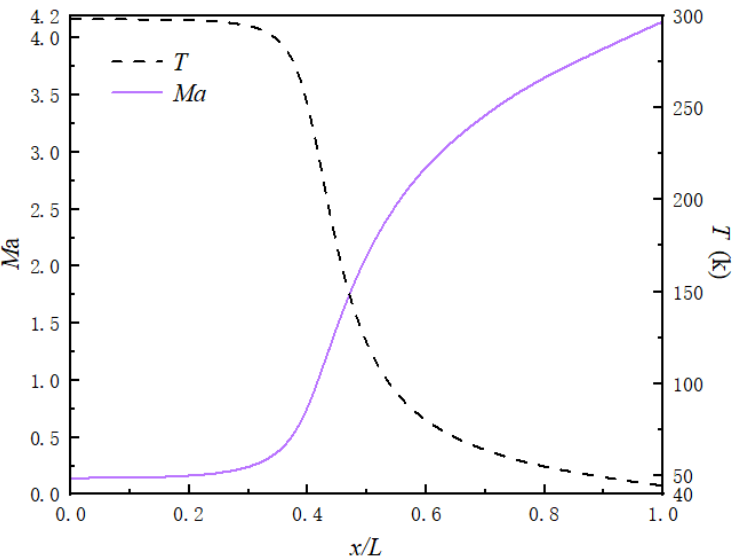
Figure 5. Centerline Mach number and temperature distribution in a micronozzle.